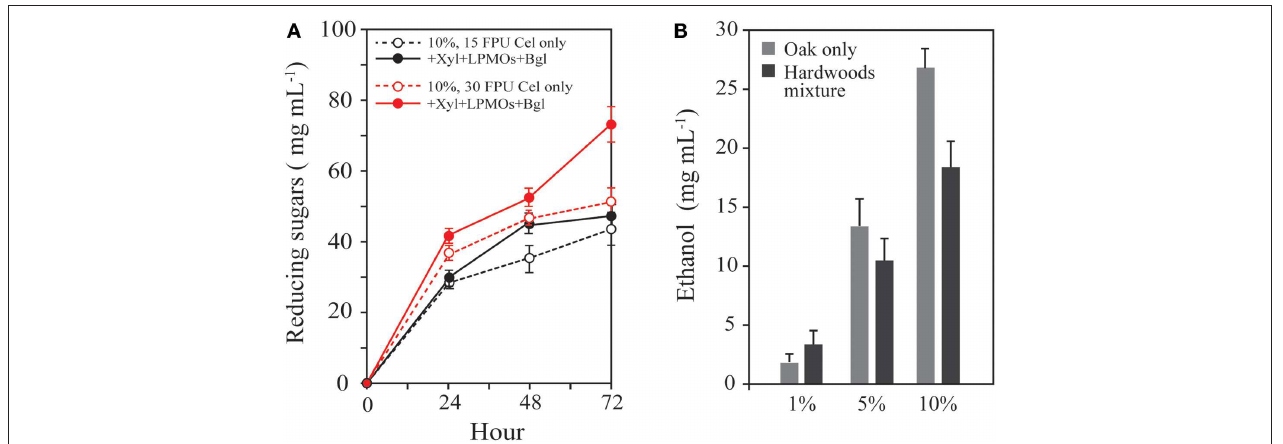
FIGURE 7 | Synergistic effect depending on the cellulase concentration and fermentation efficiency of hardwoods. (A) HPAC-pretreated oak (10%) was hydrolyzed with 15 or 30 FPU cellulase g − 1 biomass. Supplementation with xylanases, beta-glucosidase, and LPMOs was performed to minimize the end-product inhibition and structural recalcitrance of cellulose. The 30 FPU cellulase-based cocktail solution caused 52.92 ± 0.78% increment of reducing sugars from the substrate ( p = < 0.001 ), but 5.27 ± 2.32% increment in the 15 FPU cocktail solution ( p = 0.36 ) compare to the each basal enzyme. (B) Bioethanol production from the oak ( Q. acutissima ) only and the hardwood mixture ( C. sieboldii Hatus, C. japonica, L. Tulipifera L, Q. acuta thunb, M. japonicas, Q. acutissima, and P. deltoides ).